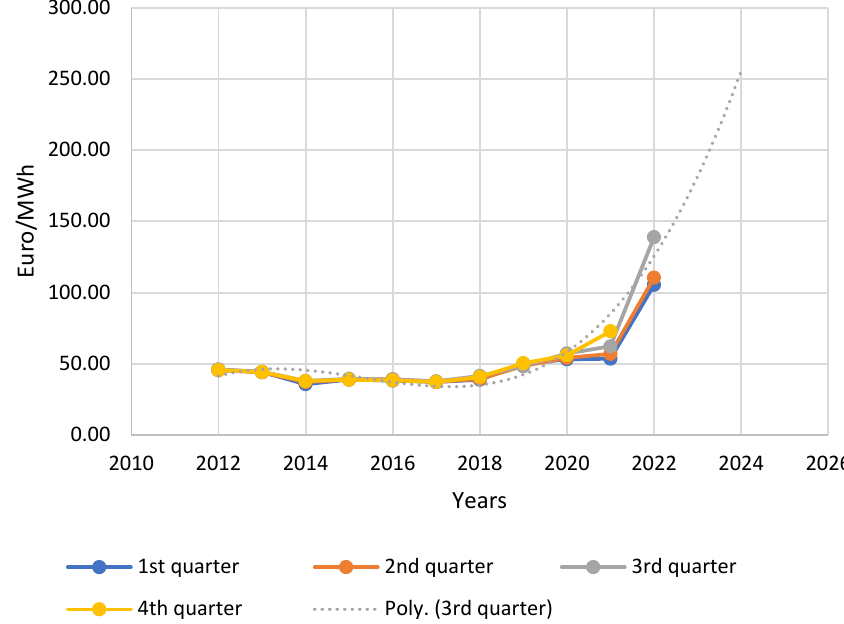
Figure 5. Chart: average quarterly price of electricity not subject to the public sale obligation [Euro/MWh], forecast using a 3rd degree polynomial: the dotted line (based on data from the energy regulatory authority).